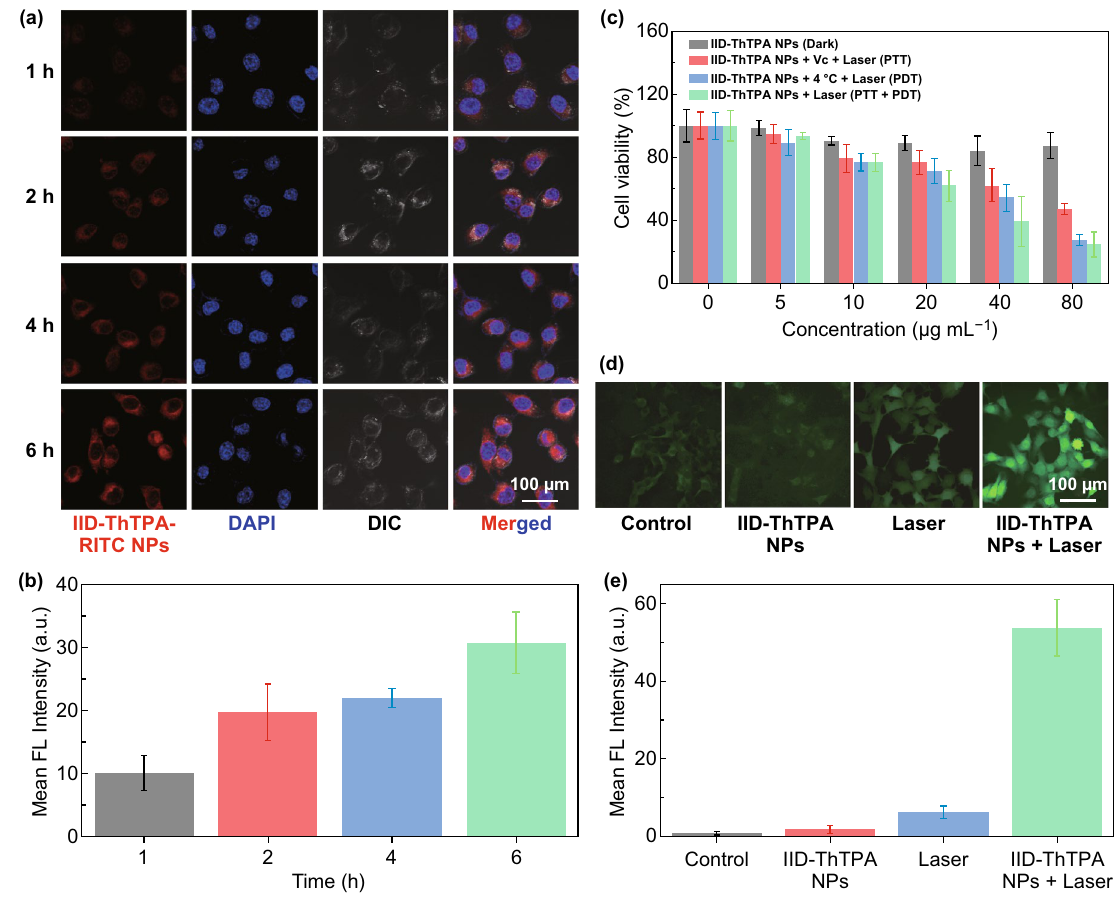
Fig. 4 In vitro phototherapy of IID-ThTPA NPs. a CLSM images of 4T1 cells after incubating with IID-ThTPA-RITC NPs for different times (1, 2, 4, and 6 h). b Quantitative analysis of RITC fluorescence intensity in a . c Cell viability of 4T1 cells incubating with IID-ThTPA NPs (0, 5, 10, 20, 40, and 80 μg mL −1 ) under different experimental conditions (dark, PTT, PDT, and PTT + PDT) (the results are presented as mean ± SD, n = 6). d Intracellular ROS level of 4T1 cells under different treatments (control, IID-ThTPA NPs, laser, and IID-ThTPA NPs + laser). e Quantita- tive analysis of DCF fluorescence intensity in